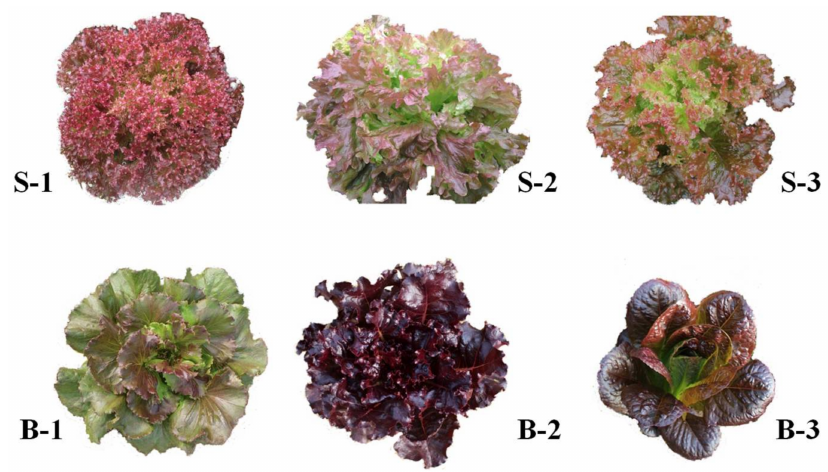
Figure 1. Morphological characterization of the six red lettuce